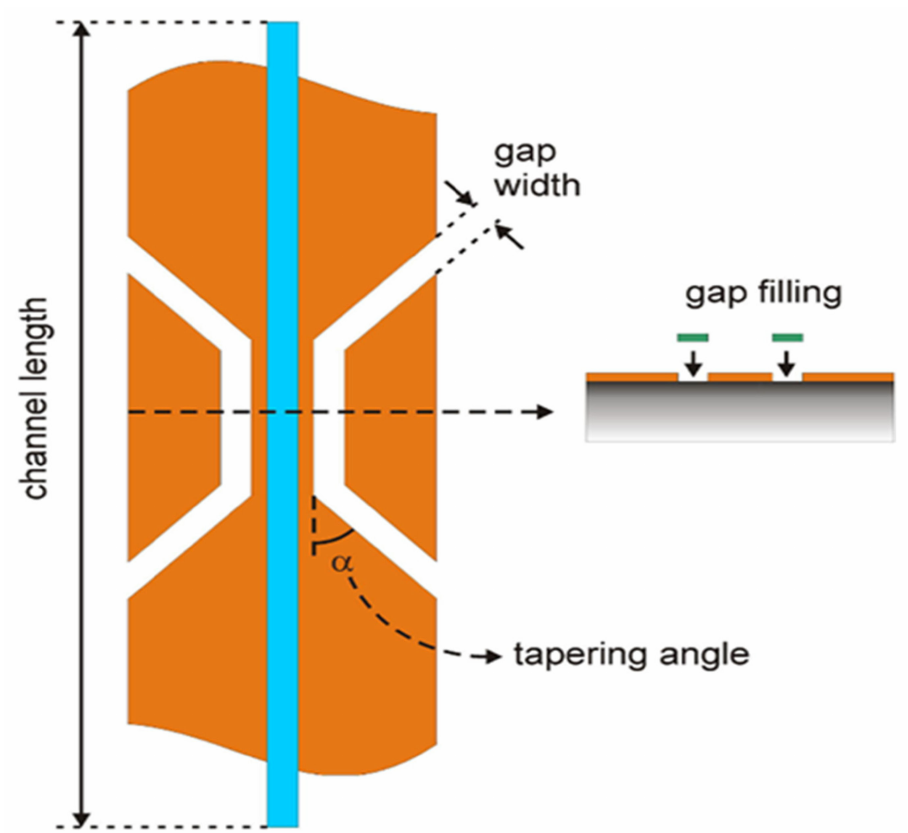
Figure 6. Parameters that are varied for optimization of the resolution. Reproduced with permis- sion. [134] Copyright 2009, Elsevier.